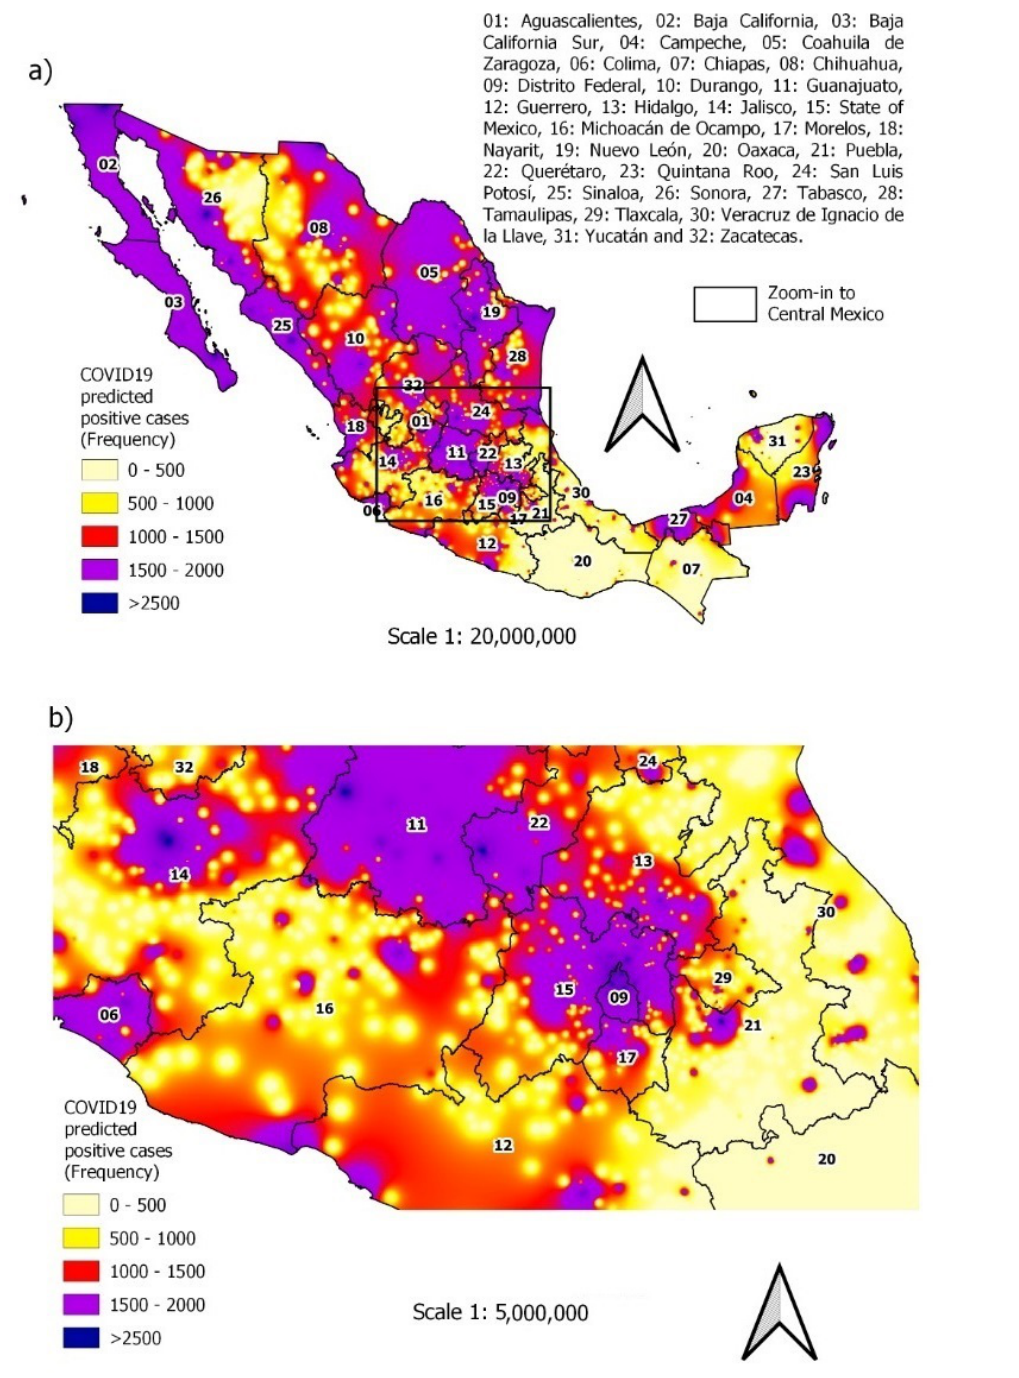
Figure 10. Predicted spatial distribution of COVID-19 occurrence from February 2020 to April 2022: ( a ) average actual occurrence with XGBoost-based logistic regression; ( b ) zoom-in to Central